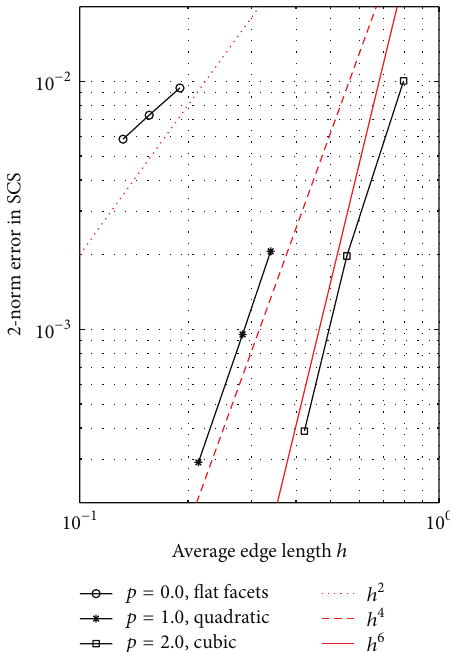
Figure 8: Error in the SCS versus the average edge lengths in the models, for the same torus used in Figure 7. MFIE results from Figure 7 are compared to ideal asymptotic rates of 𝑂(ℎ 2 ) , 𝑂(ℎ 4 ) , and 𝑂(ℎ 6 )